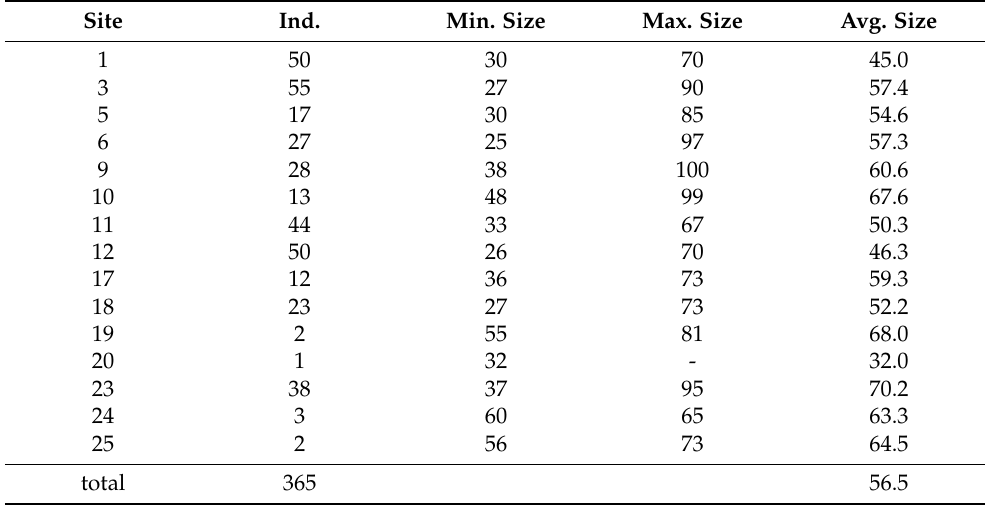
Table 9. Sampling results of the trawl survey in the Southern Sea and Jeju coastal waters. Site